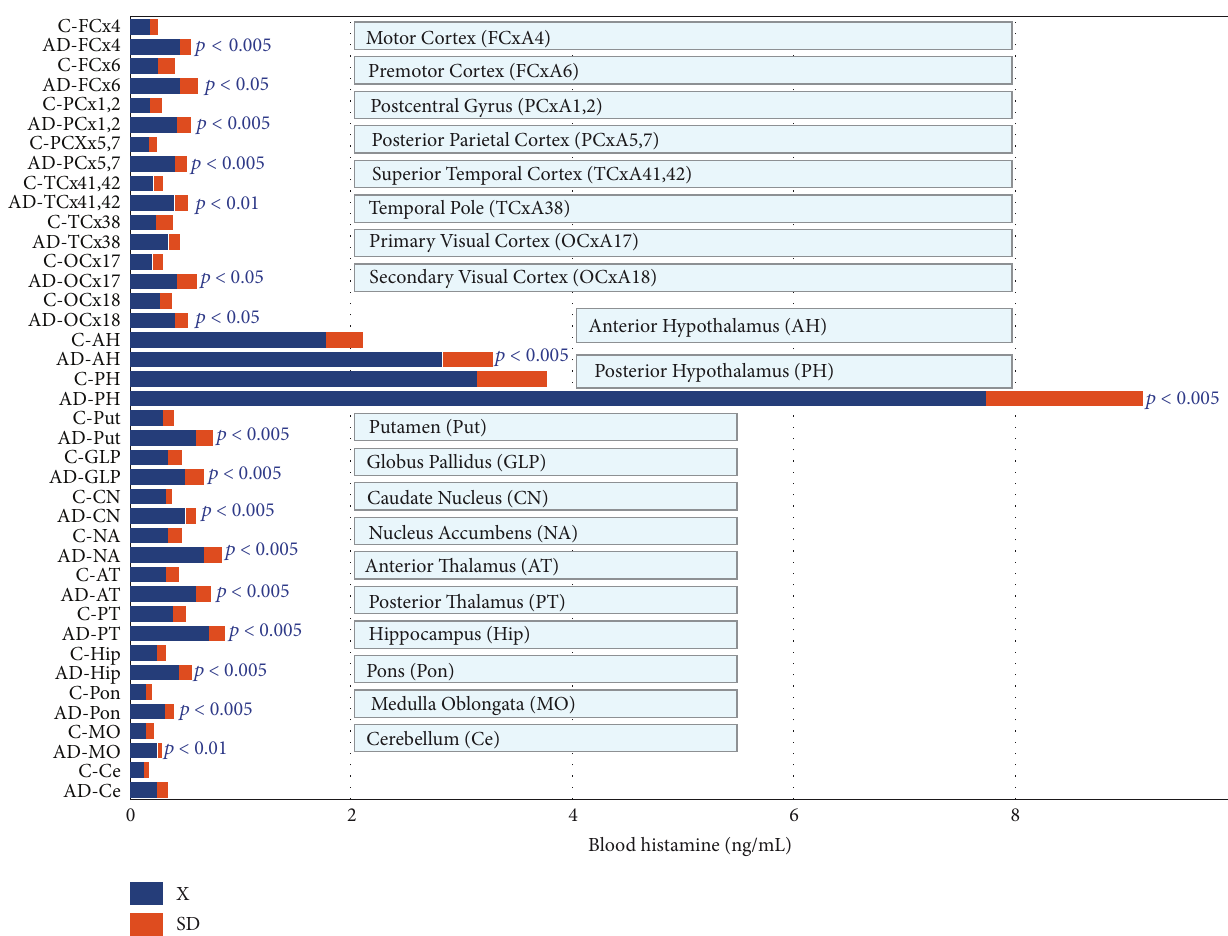
Figure 3: Changes in histamine levels in different brain regions from patients with Alzheimer’s disease (AD). Notice the presence of a high concentration of HA in most brain regions of AD patients as compared with that of control (C) brains.